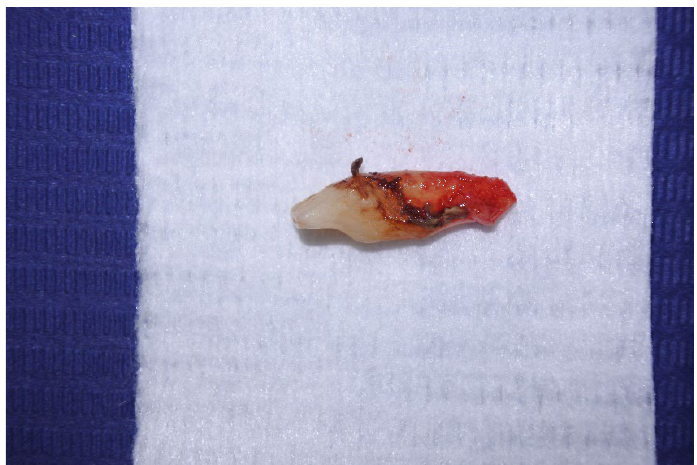
Figure 1. Extracted tooth without appreciable decay or leakages on crown